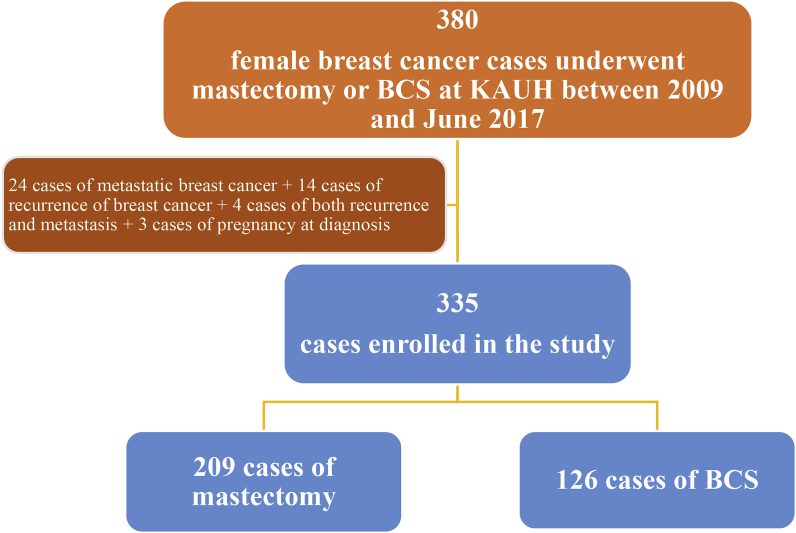
Flow diagram for the process of patients' enrollment in the study.